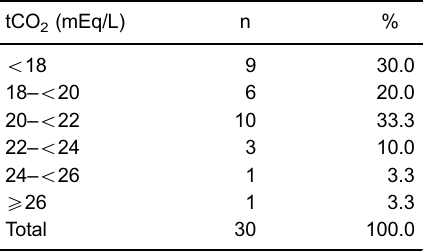
Table 3. Range of pre-dialysis total CO 2 (tCO 2 ) of the midweek dialysis session in the studied